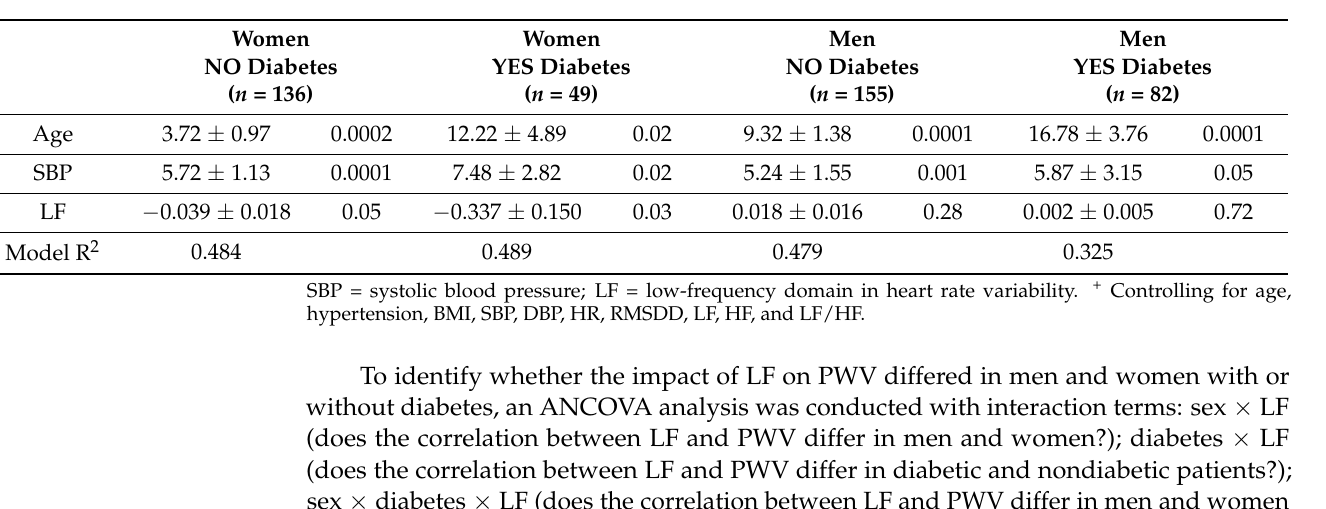
Table 2. Independent significant determinants of PWV in women and men with or without diabetes, identified by multiple regression analysis (regression beta coefficient +/ − standard error) +